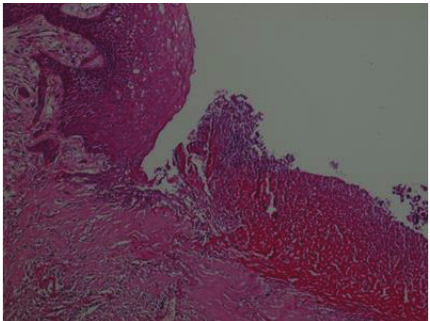
Figure 4: In the upper-left part, there is normal, well-preserved esophageal mucosa, while in the lower-right region there is an ulcer field disrupting the mucosa (H&E stain, × 100).